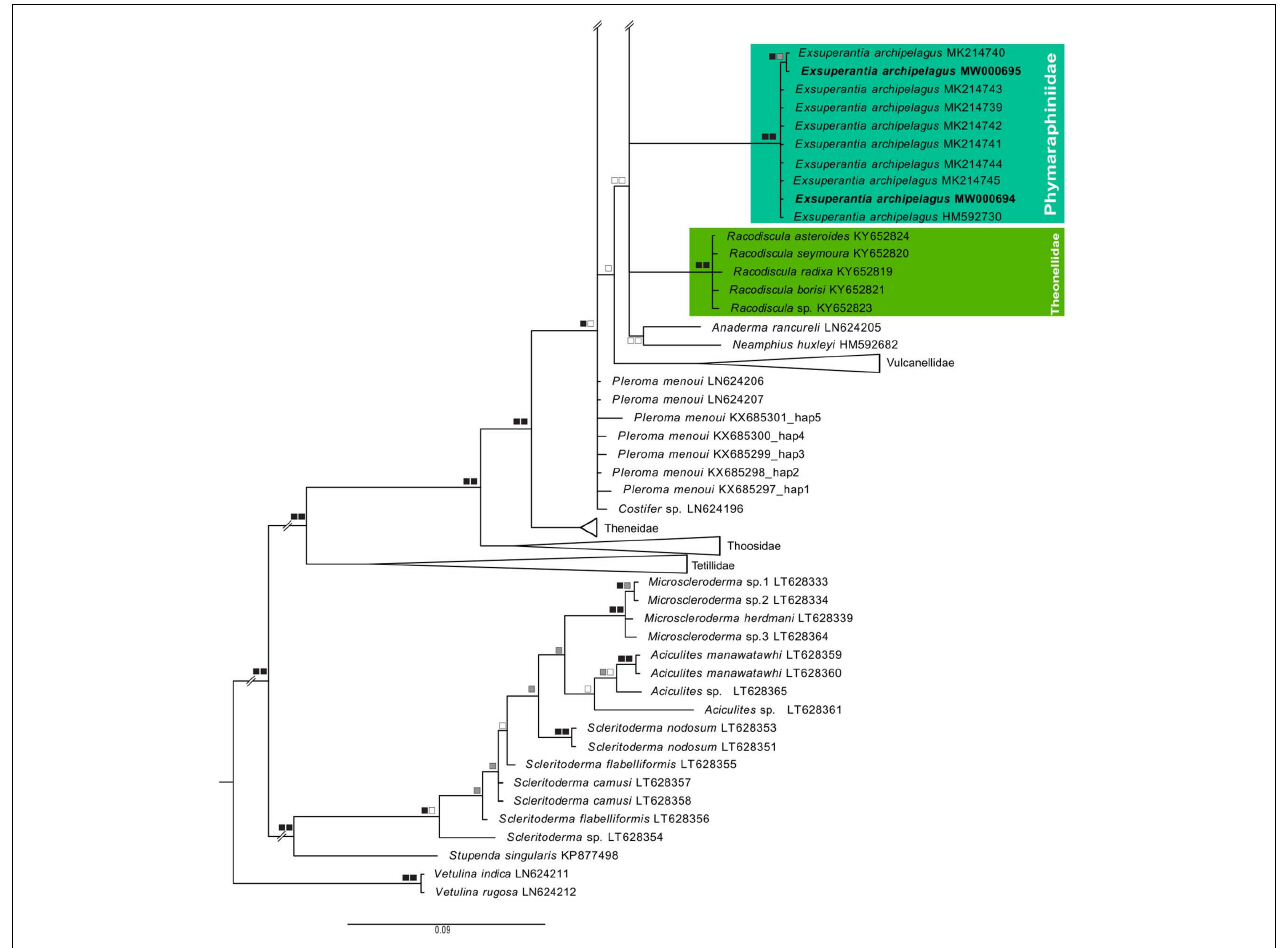
FIGURE 5 | Phylogenetic reconstruction of the mtDNA COI gene for lithistids recorded in the Azores archipelago. Bayesian posterior probabilities (PP, left square) and maximum likelihood bootstrap support (BS, right square) values are provided on the branches. If only one square is shown, it means the clade was not retrieved in the Maximum Likelihood analysis. Sequences generated in this study are in bold. Families encompassing lithistid species found in the present study are highlighted in